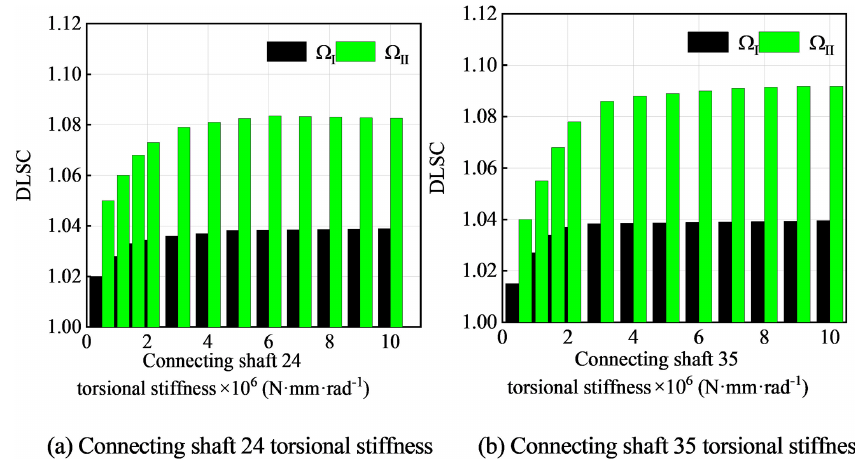
Figure 17. Influence of torsional stiffness of connecting shaft on the dynamic load-sharing coefficient.